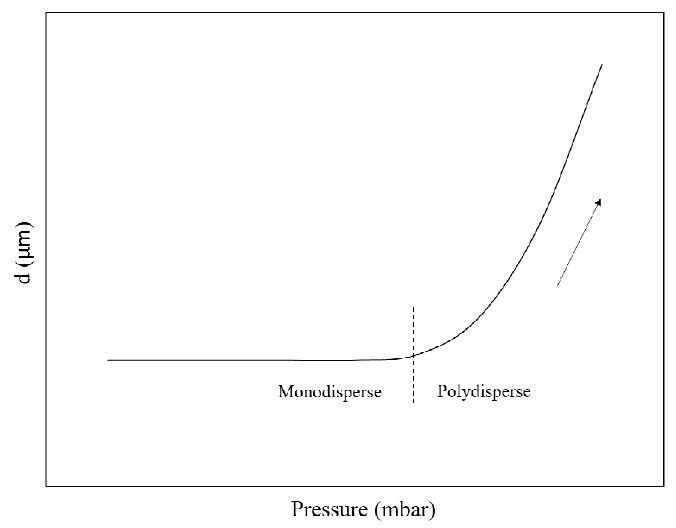
Figure 4. Schematic diagram showing the e ff ect of dispersed phase pressure on the bubble (droplet) size distribution.